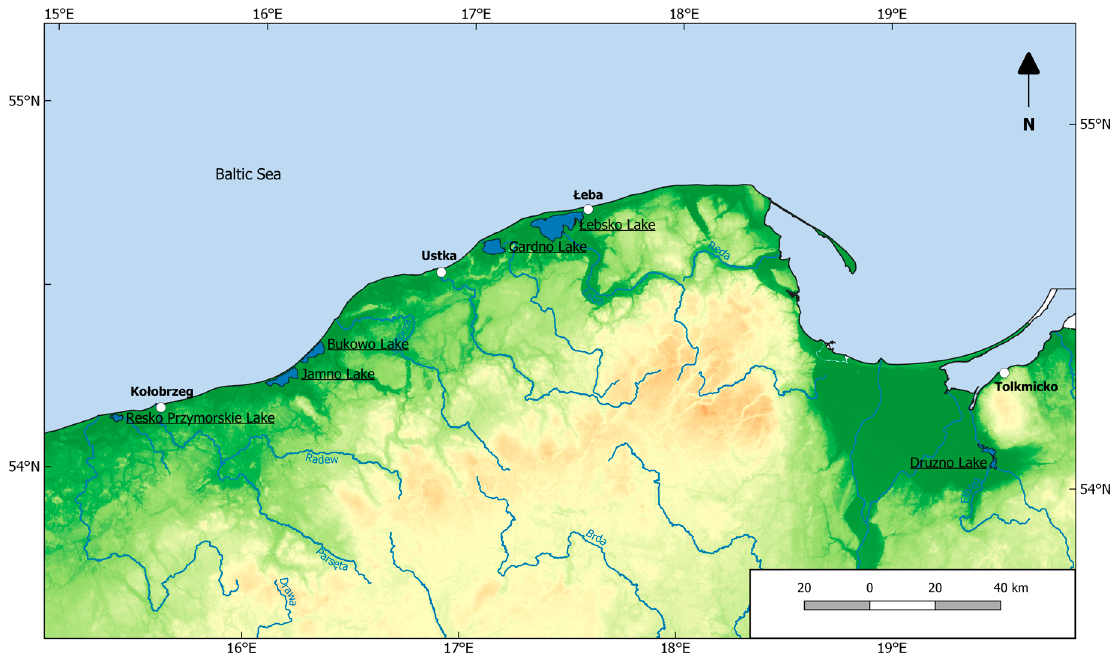
Figure 1. Location of lakes and water gauge stations in the Baltic Sea. Table 1. Morphometric data of the studied lakes.